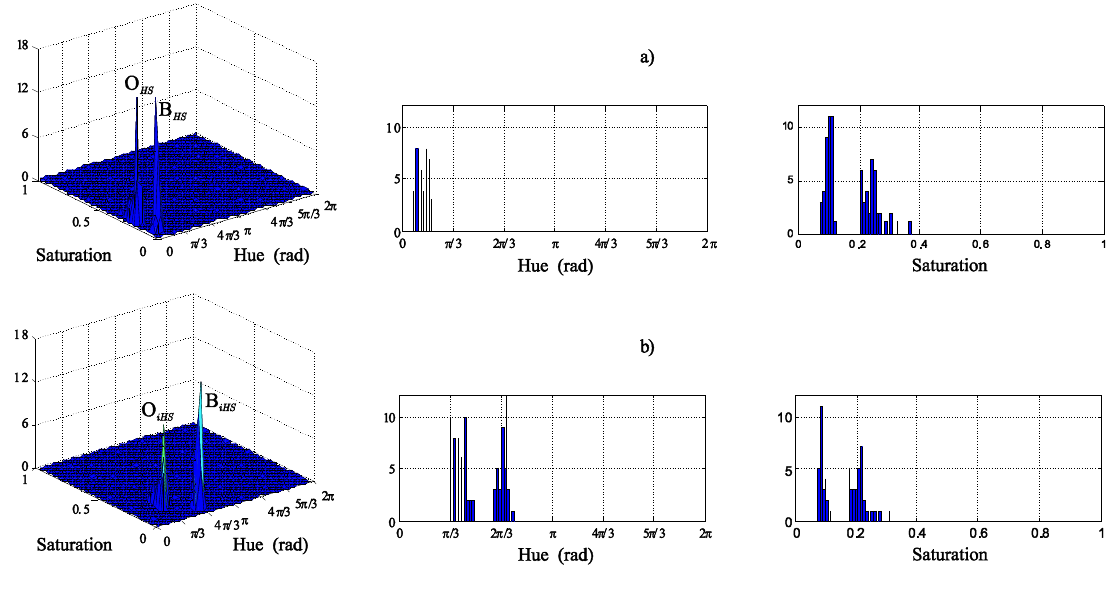
Figure 13. Histograms of the O colour